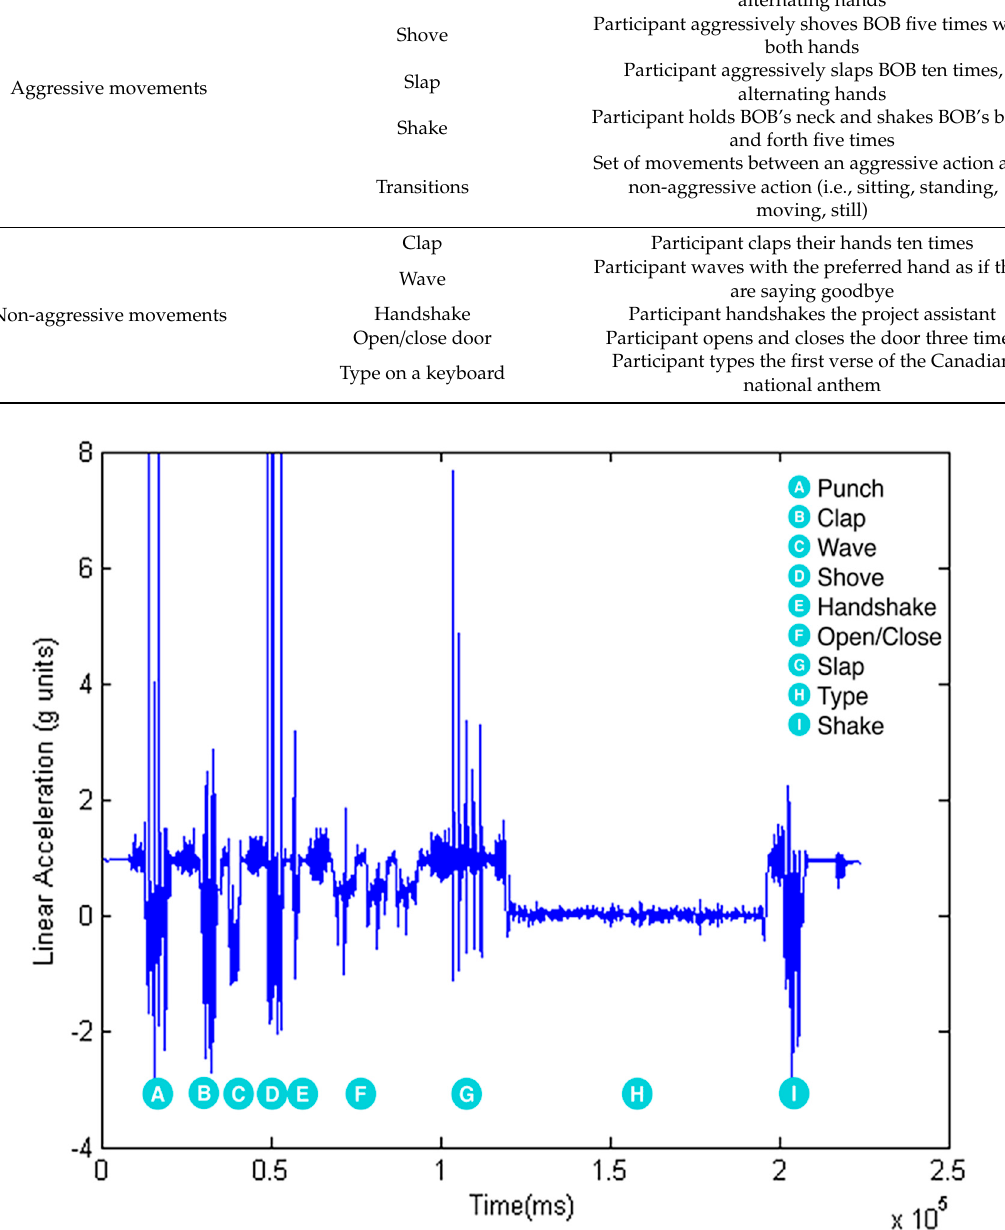
Figure 2. Accelerometer linear acceleration (x-axis).